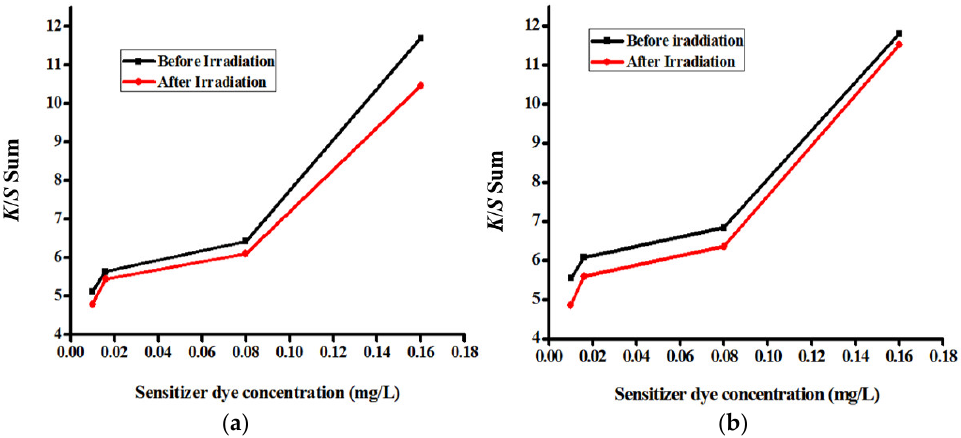
Figure 8. K / S sum values against sensitizer dye concentration: ( a ) Only RB-25 dye and ( b ) RB-25 dye with RhB stain.